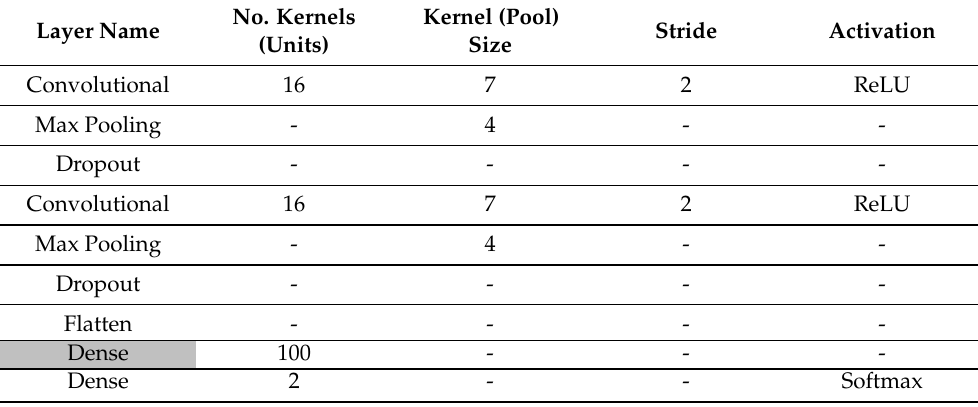
Table 3. CNN architecture with dropout rate set to